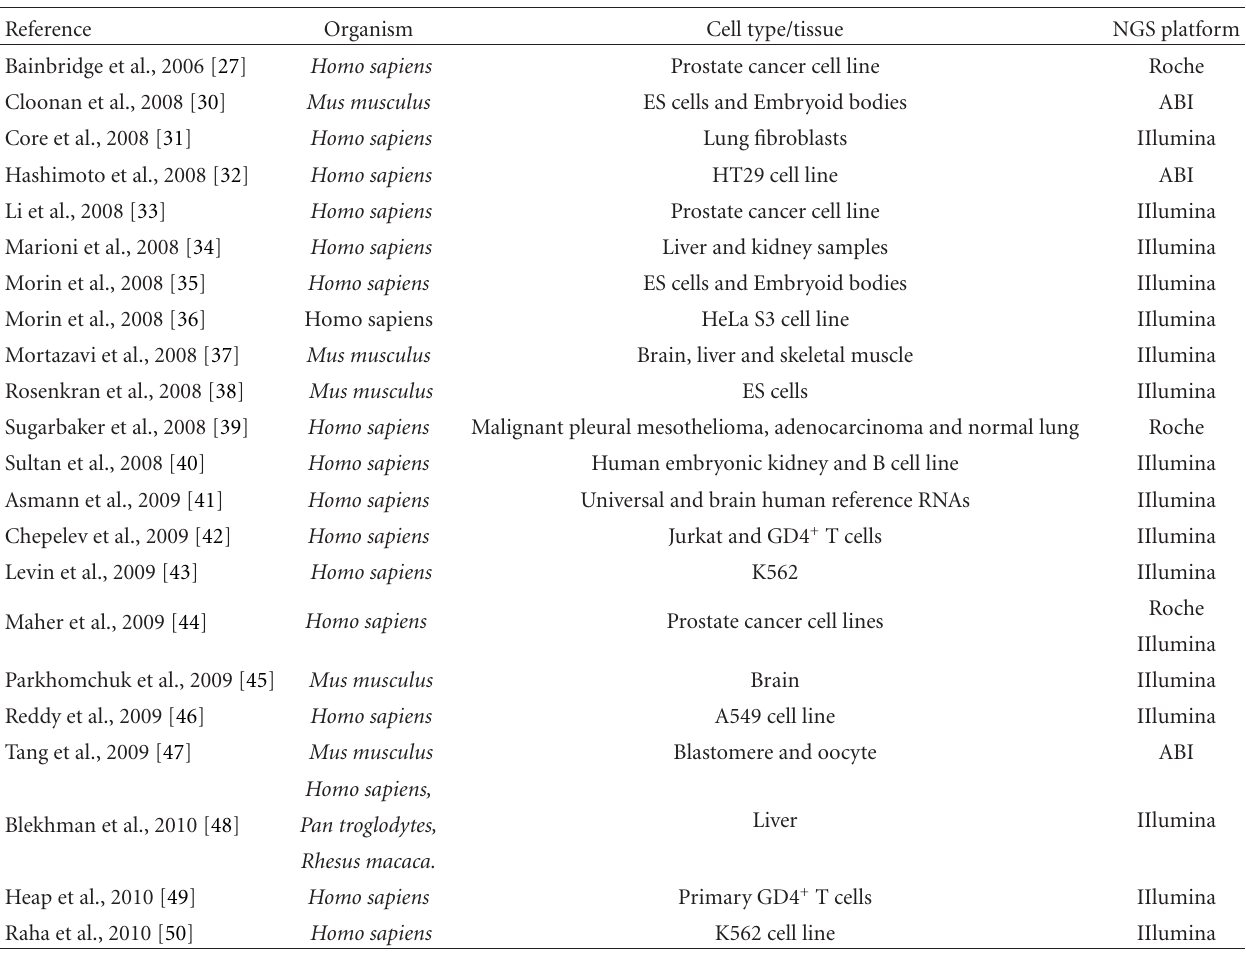
Table 1: Selection of papers on mammalian